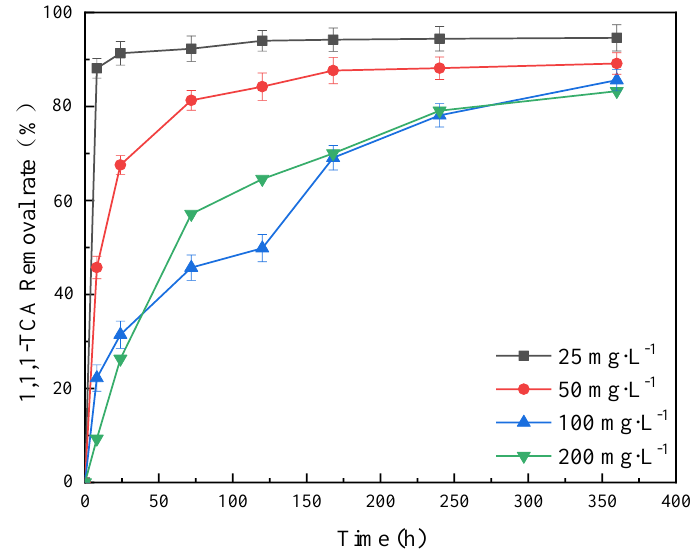
Figure 7. Effects of 1,1,1 − TCA concentration on 1,1,1 − TCA removal (mass fraction of nZVI: 20%; composite dosage: 1.00% w/v ).